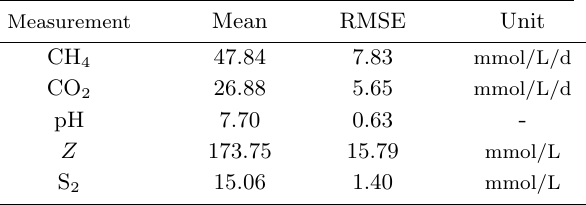
Table 10: RMSE of error (deviation) between exper- imental and simulated measurements with adapted model for validation data